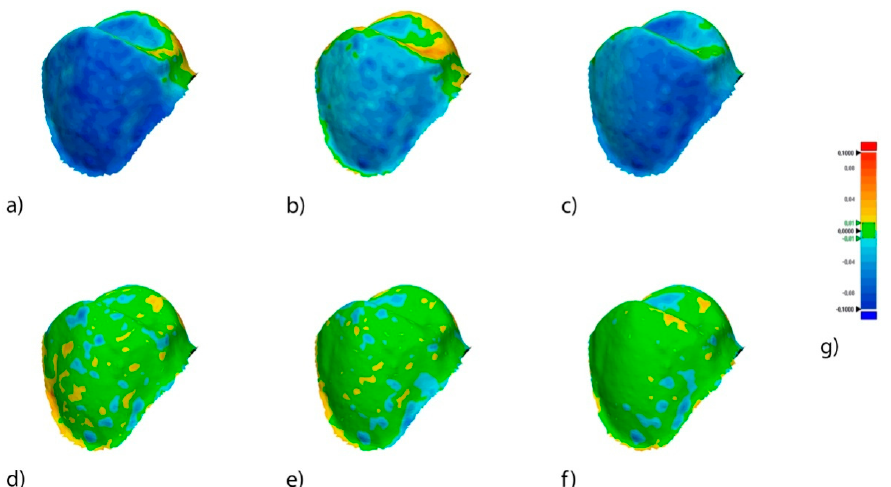
Figure 4. Buccal perspective of the alignment rate of the segmented and aligned STL1 and STL2 ( a ), STL1 and STL3 ( b ), and STL1 and STL4, and ( d ) the buccal view of the segmented and re-aligned ( a ) STL1 and STL2 ( d ), STL1 and STL3 ( e ), and STL1 and STL4 ( f ). Reddish colors indicate an increase in volume, bluish colors indicate a decrease in volume, and green represents an accurate alignment ( g ).